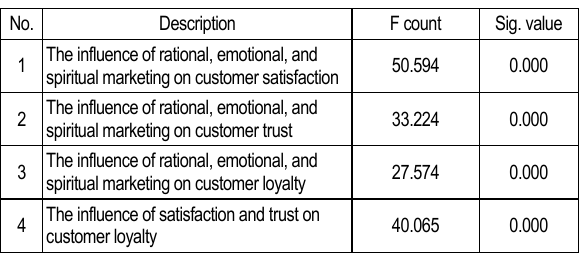
Table 3. Result of simultaneous testing